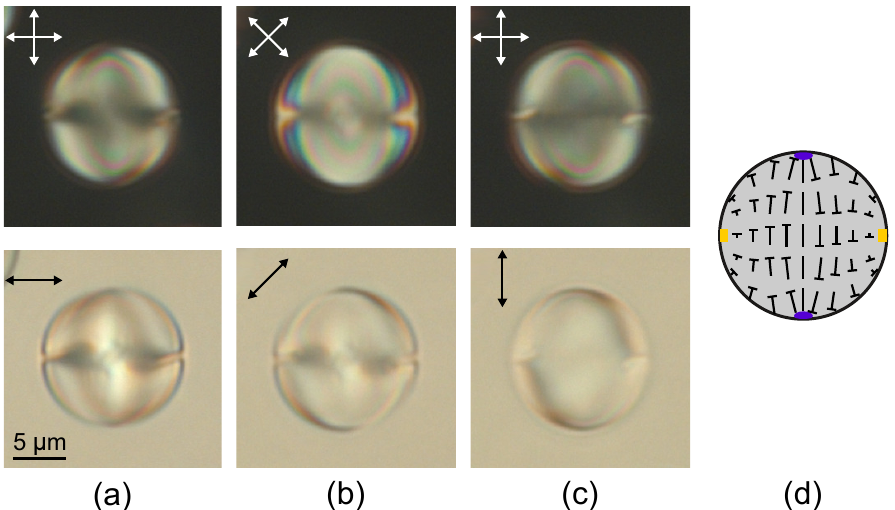
Figure 2. POM photos of the cholesteric droplets at N 0 = 2.9 taken in the crossed polarisers (top row) and without analyser (bottom row). The circular defect plane is perpendicular to the film plane. The polariser is oriented parallel ( a ), at angle 45 ◦ ( b ) and perpendicular ( c ) to the circular defect plane. Scheme of the director orientation in the central droplet section ( d